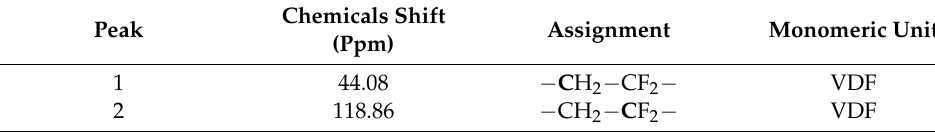
Table 3. Assignment of the chemical shift of 13 C{ 1 H} CP-MAS spectrum.